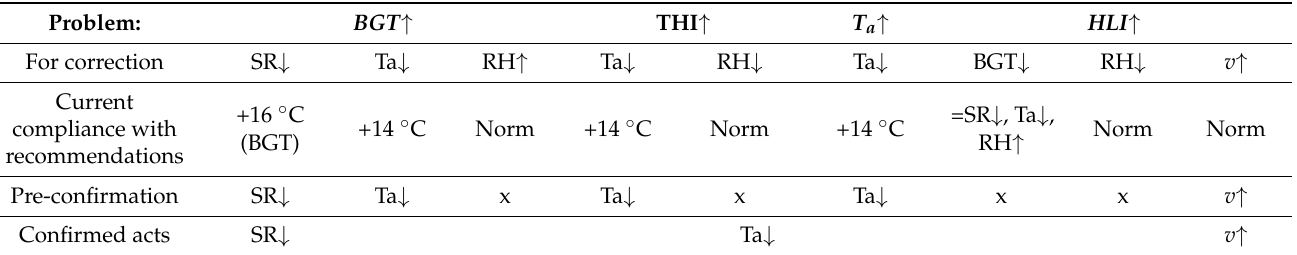
Table 6. Determining factors for change.